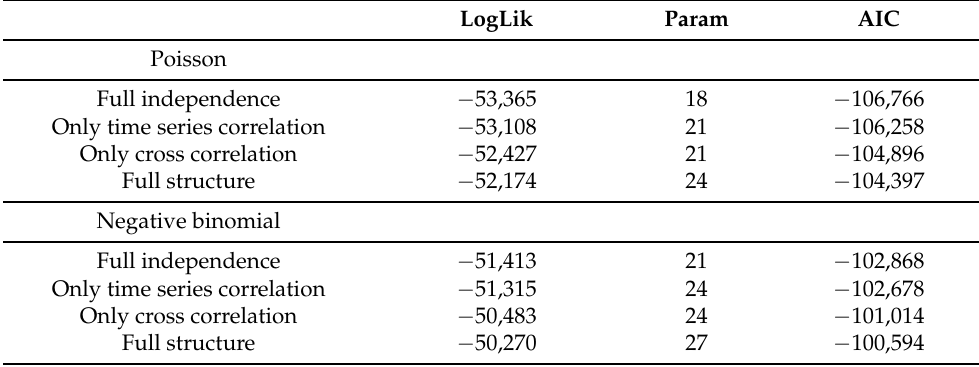
Table 2. Fitted models.